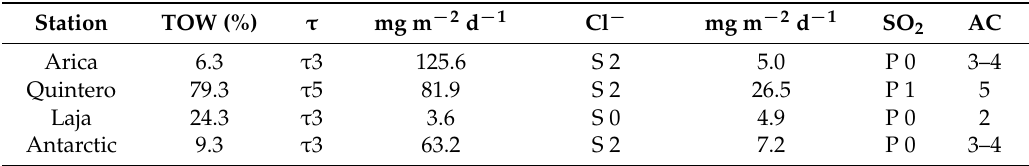
Table 3. Atmospheric corrosivity categories (AC) of the distinct stations, based on pollution classification due to Time of Wetness ( τ ), airborne salinity contamination (Cl − ) and sulfur compounds based on sulfur dioxide (SO 2 ) concentration